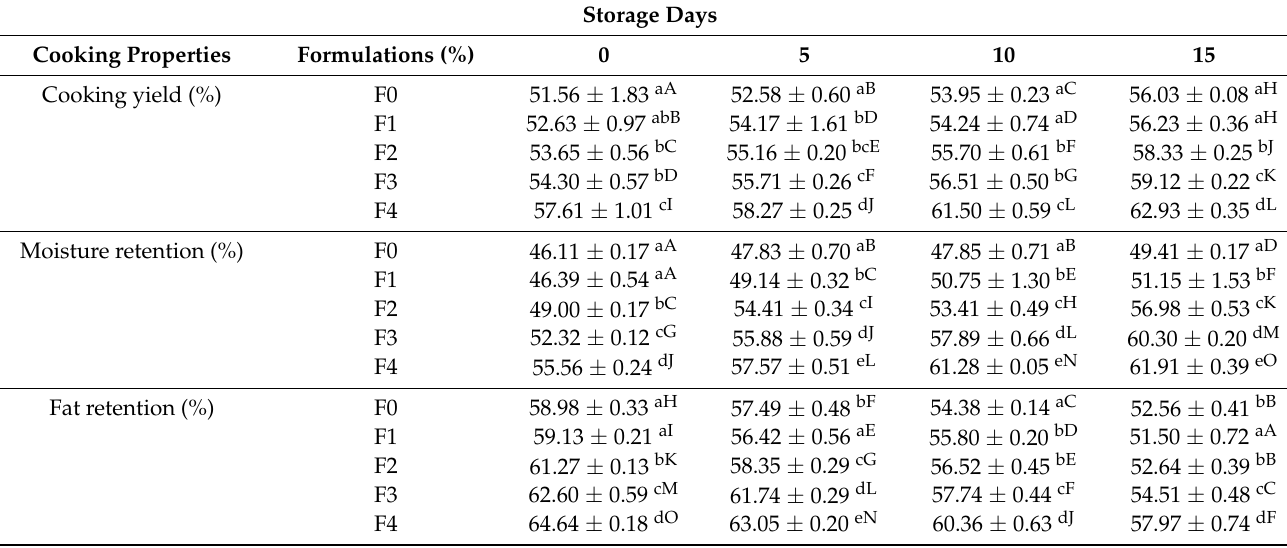
Table 5. Effects of MOLP on cooking properties of ground beef stored at 4 ± 1 ◦ C for 15